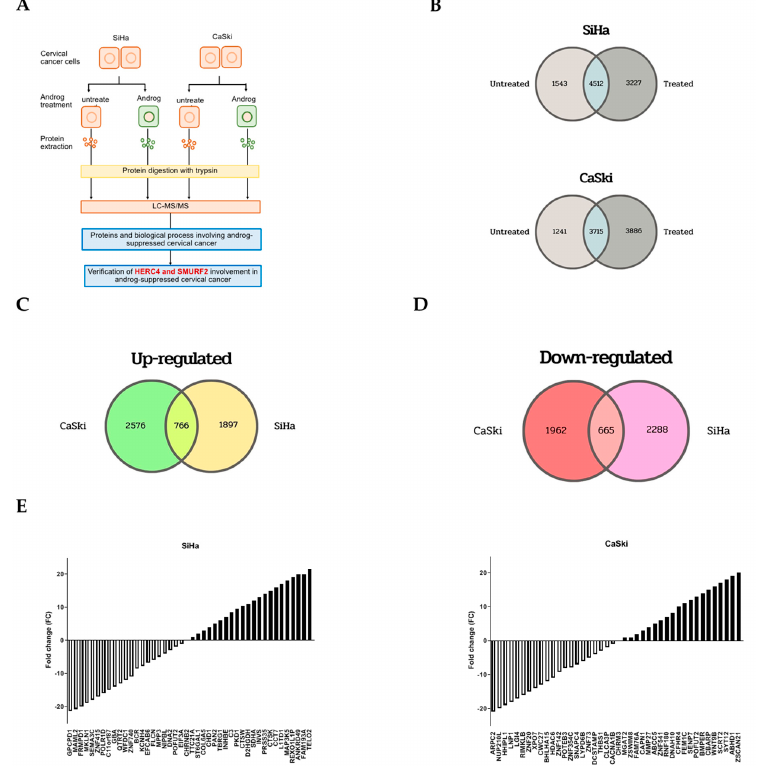
Figure 3. Identification of differentially expressed proteins in Androg-treated HPV16-positive cervical cancer cell lines. ( A ) A schematic diagram exemplified the workflow of proteomic analysis after treatment by Androg with LC-MS/MS. SDS-PAGE was performed using equal amounts of proteins from Androg-treated sublines and their parental, then followed by trypsin digestion. The fractions were injected to LC − MS/MS apparatus. The Proteome Discoverer program, Mascot software, was used as the search engine for the data searching and collection. ( B ) The quantified numbers of proteins in both SiHa (upper) and CaSki (lower) experiments. ( C , D ) The numbers of proteins that were determined to be up-regulated ( C ) or down-regulated ( D ) in two Androg sublines, including SiHa, and CaSki cells. Venn diagrams demonstrated the overlap between identified proteins in the two sets. The total number of identified proteins in each set was listed. ( E ) The relative expression levels of differentially expressed proteins in Androg-treated sublines (SiHa = left; CaSki = right) compared with the untreated